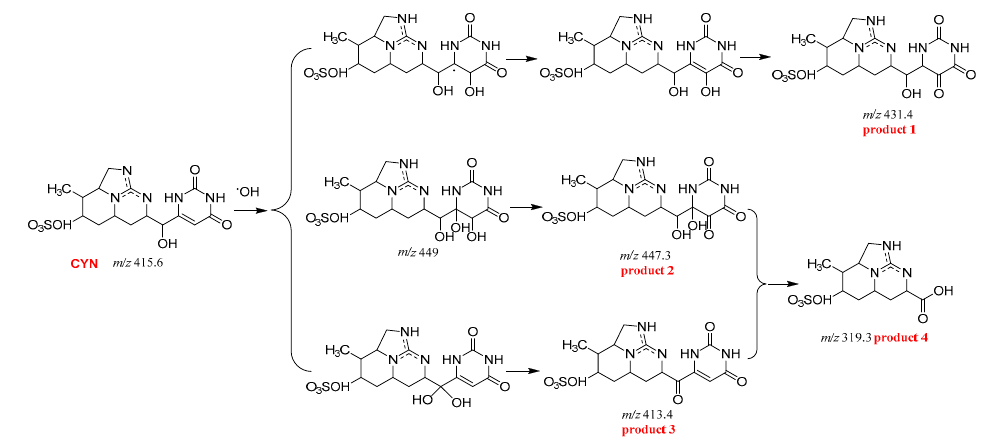
Figure 6. Proposed detoxification pathways of CYN by pyrite.